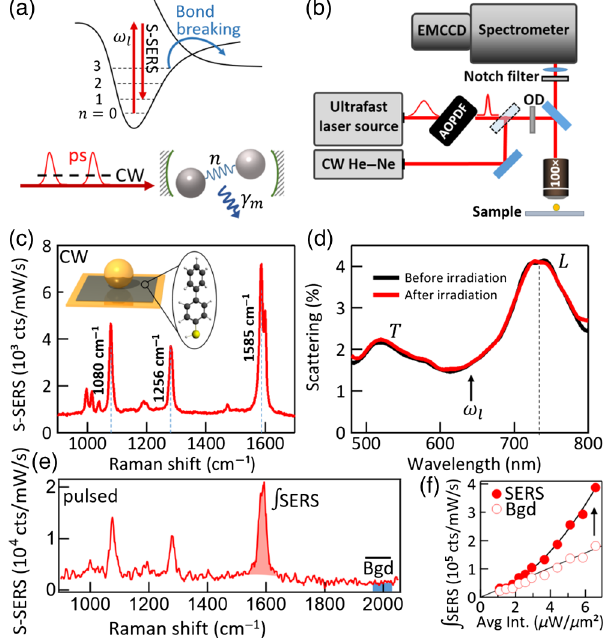
FIG. 1. Molecular optomechanics. (a) Energy diagram for ground and excited molecular vibrational states n (top) pumped by laser at ω , with schematic optomechanical cavity (bottom). l The vibrational decay rate is γ . (b) SERS setup for single- m nanoparticle studies, using continuous (CW) or ps pulsed excitation. (c) Stokes S-SERS from single 80-nm gold nano- particle-on-mirror (NPoM, geometry in inset), with biphenyl-4- thiol (BPT) self-assembled molecular monolayer spacer. (d) Dark-field scattering from single gold NPoM before (black) and after (red) 633-nm laser irradiation with average intensity I ¼ 2 μ W = μ m 2 . Coupled plasmon mode ( L ) and transverse mode ( T ) resonances are marked. (e) Pulsed ps S-SERS from single NPoM, showing extraction of integrated SERS peaks and average background. (f) Power dependence of SERS (nonlinear) and background (linear)